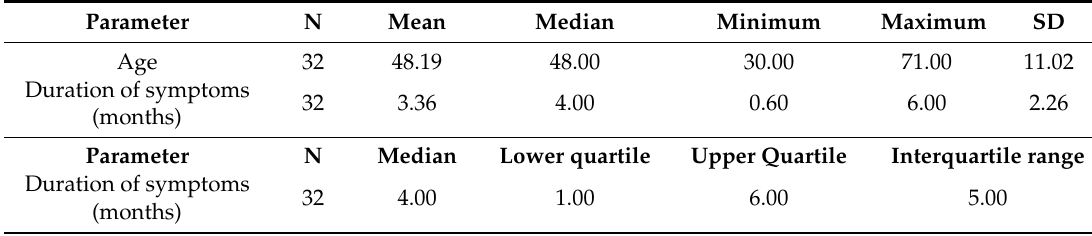
Table 1. Characteristics of the study